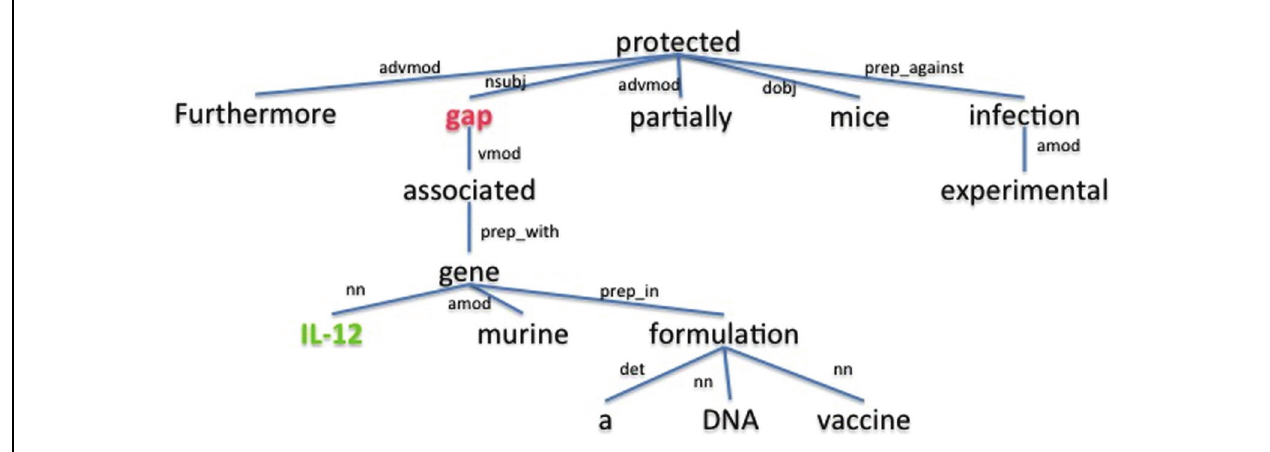
FIGURE 3 | The dependency parse tree of a sample sentence. The tree is generated for the sentence “Furthermore, gap associated with murine IL-12 gene in a DNA vaccine formulation partially protected mice against experimental infection.” from the abstract of (Rosinha et al., 2002). Host and pathogen genes identified by SciMiner are shown in green and red, respectively. The Stanford parser was used to generate the parse tree. advmod, adverb modifier; amod, adjectival modifier; det, determiner; dobj, direct object; nn, noun compound modifier; nsubj, nominal subject; prep_against, preposition against; prep_in, preposition in; prep_with, preposition with; vmod, reduced non-finite verbal